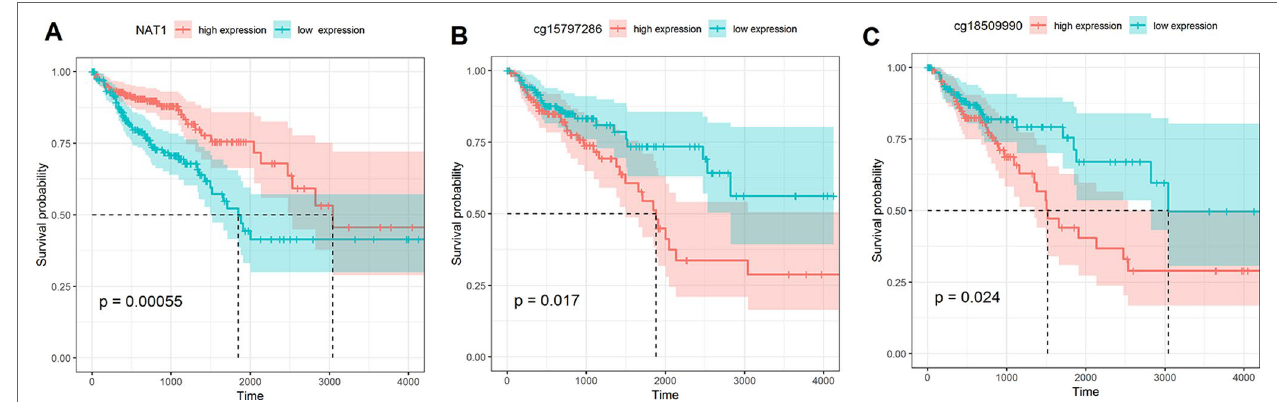
FIGURe 3 | (A) Kaplan–Meier curve of N - acetyltransferase 1 ( NAT1 ) mRNA expression in COAD; (B) Kaplan–Meier curve of cg15797286 in COAD; (C) Kaplan–Meier curve of cg18509990 in COAD.